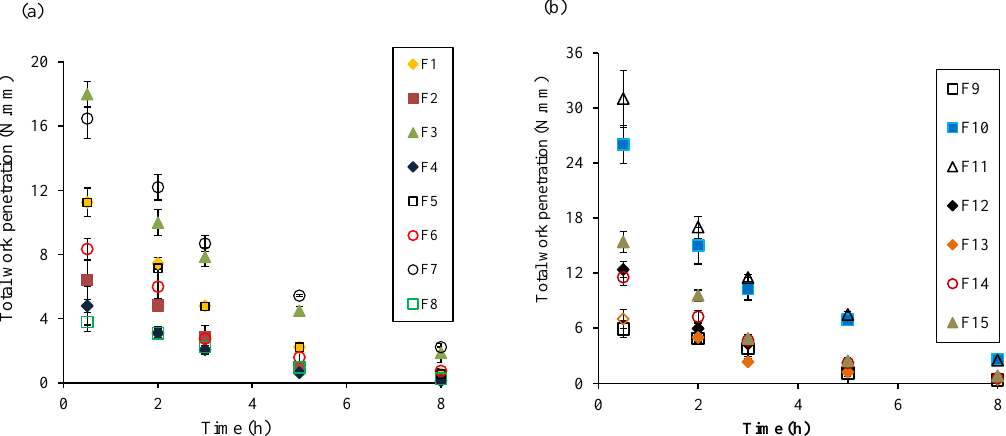
Figure 4. Figure 4. Total work of penetration vs. time profiles of various formulations based on the BBD experimental design, ( a ) F1–8 and ( b )